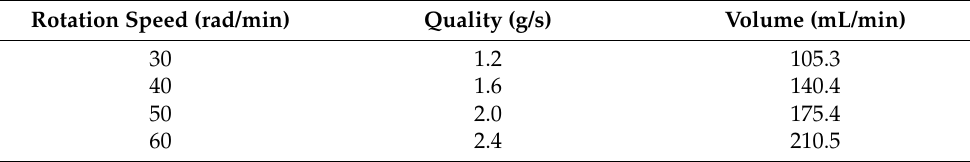
Table 1. The relationship between peristaltic pump rotation speed and discharge